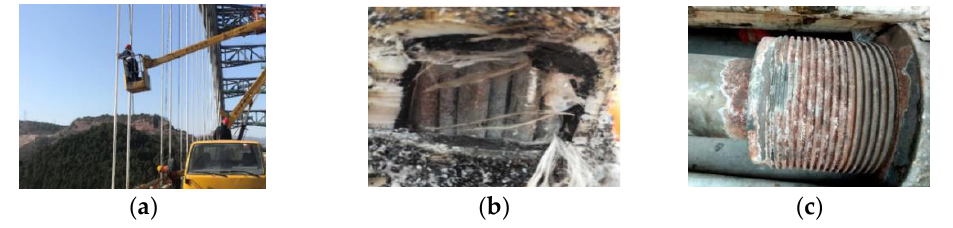
Figure 3. Corrosion inside suspender. ( a ) Overall inspection of suspender, ( b ) Internal corrosion of suspender and ( c ) Corrosion of anchor cup.